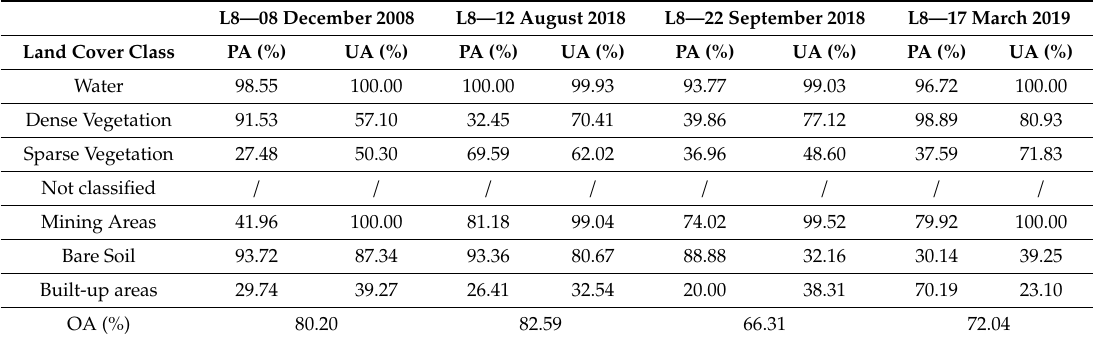
Table 12. OA, PA, and UA obtained through the application of Normalized Di ff erence Bareness Index (version 2) (NDBIaI2) on the data acquired by Landsat 8 mission. UA: UA, user’s accuracy; PA, producer’s accuracy; OA, overall